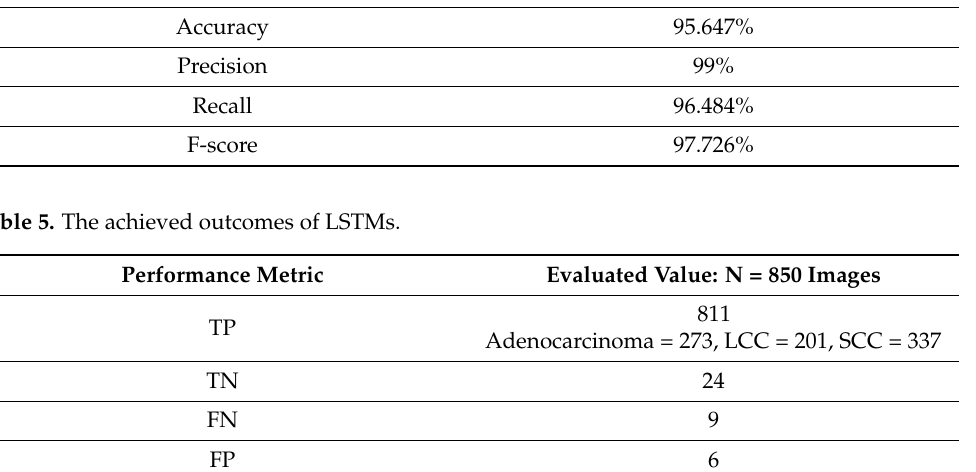
Table 4. The evaluated performance metrics of VGG-19.